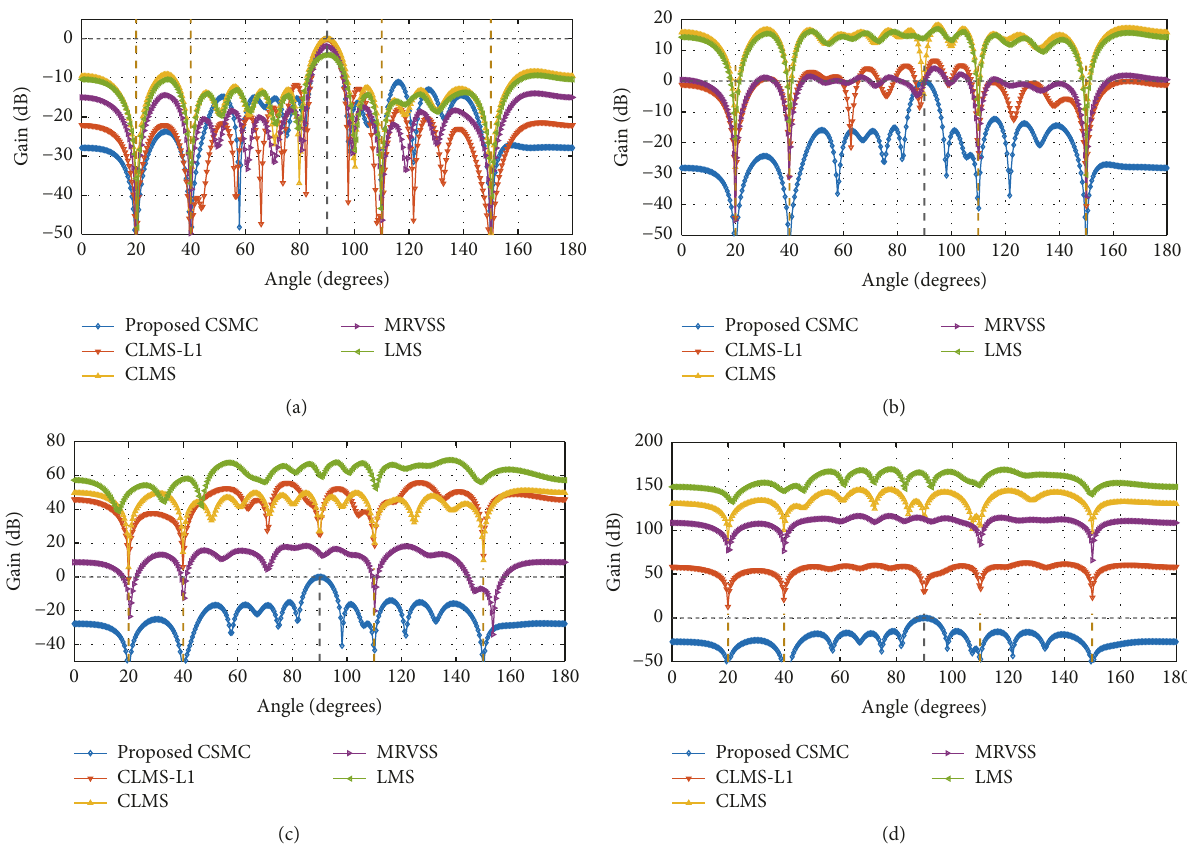
Figure 2: Beampatterns of the proposed and the other existing beamformers with different 𝛼 : (a) 𝛼 = 1.65 ; (b) 𝛼 = 1.5 ; (c) 𝛼 = 1.35 ; (d) 𝛼 = 1.2